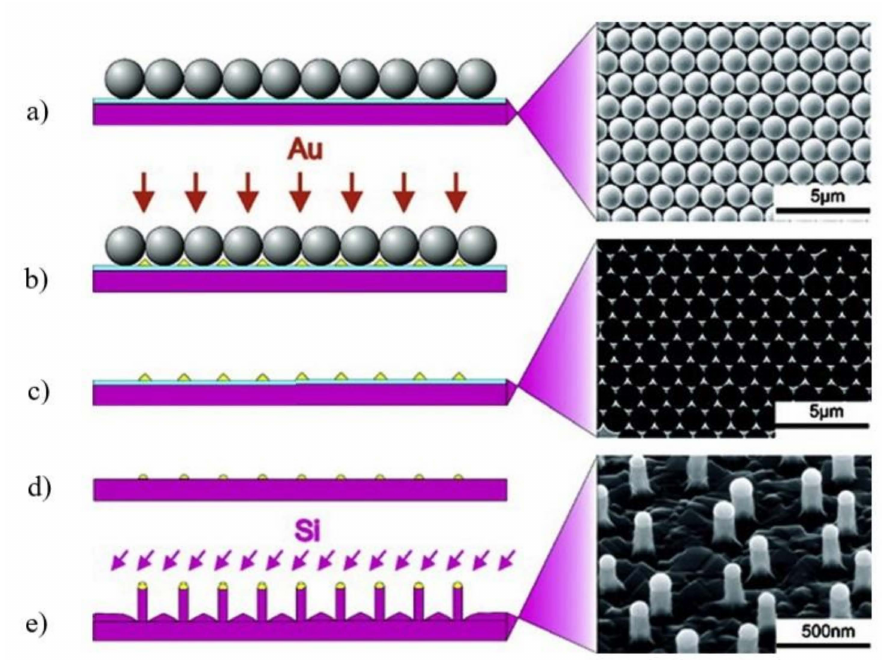
Figure 7. Nanosphere lithography applied to the preparation of ordered vertical Si NWs using gold- catalyzed VLS growth: ( a ) deposition of polystyrene nanoparticles on a silicon substrate covered with a 2 nm thick oxide layer (on the right a scanning electron image is reported); ( b ) thermal evaporation of gold; ( c ) removal of the nanospheres layer (on the right a scanning electron image of the patterned substrate is reported); ( d ) annealing and removal of the oxide layer; ( e ) NW growth (on the right a scanning electron image of the NW array is reported). Reprinted with permission of